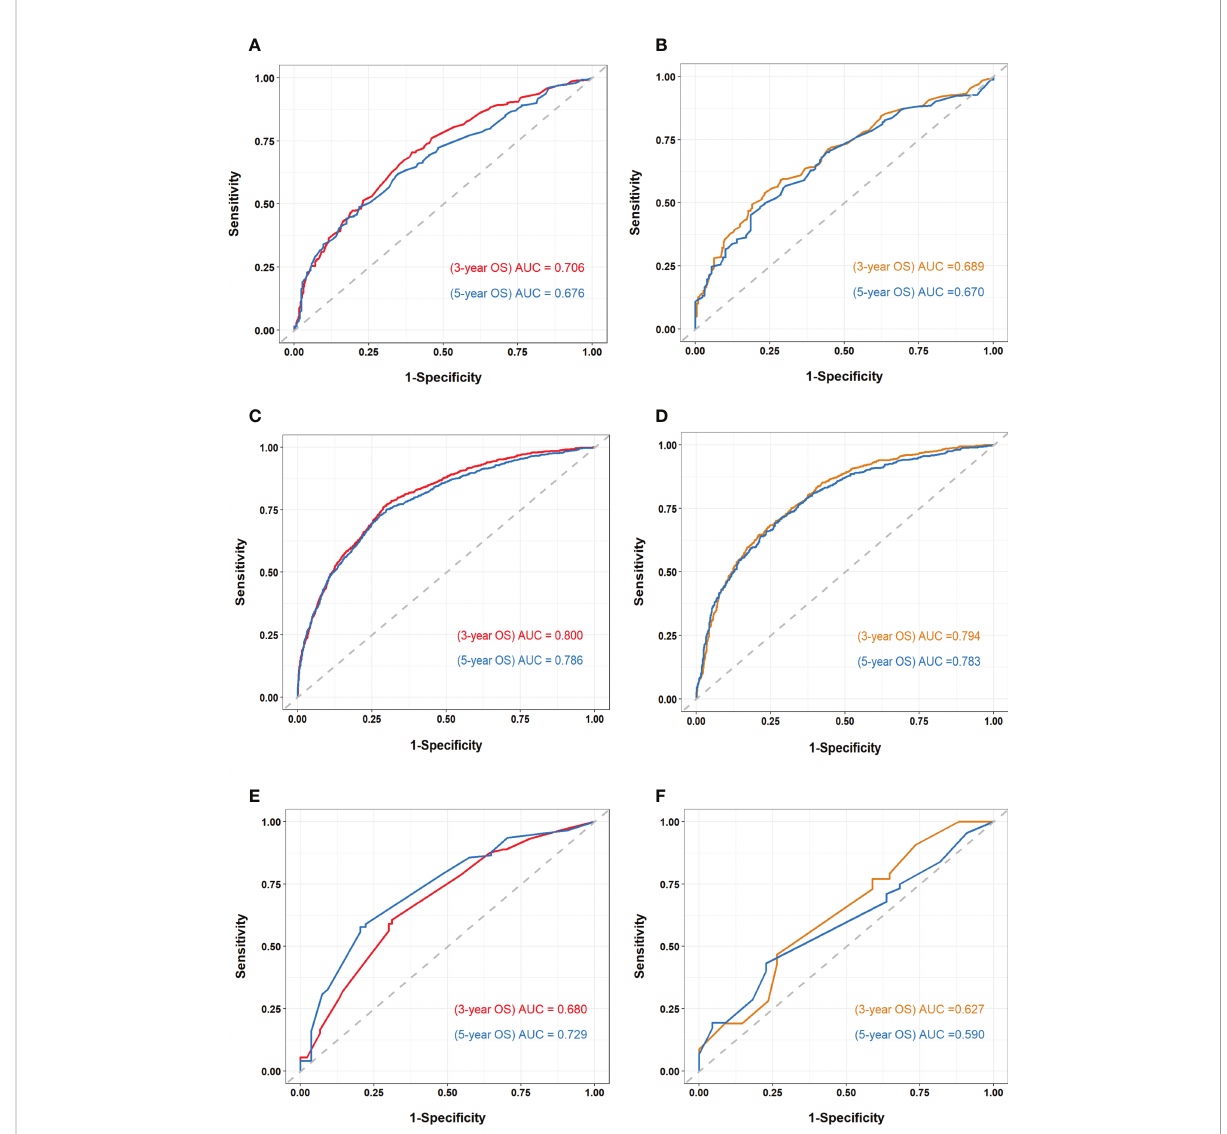
FIGURE 5 Receiver operating characteristic (ROC) curve and area under the ROC curve (AUC) of all cohorts (A) ROC curve and AUC of the fi rst cohort training set. (B) ROC curve and AUC of the fi rst cohort validation set. (C) ROC curve and AUC of the second cohort training set. (D) ROC curve and AUC of the second cohort validation set. (E) ROC curve and AUC of the third cohort training set. (F) ROC curve and AUC of the third cohort validation